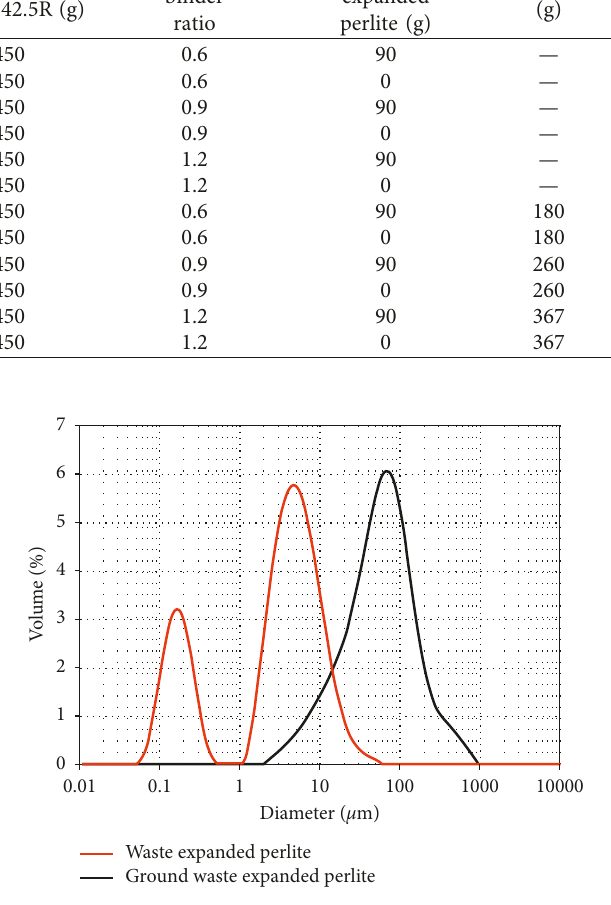
Figure 1: Grain size distribution of ground waste expanded perlite before and after the grinding.